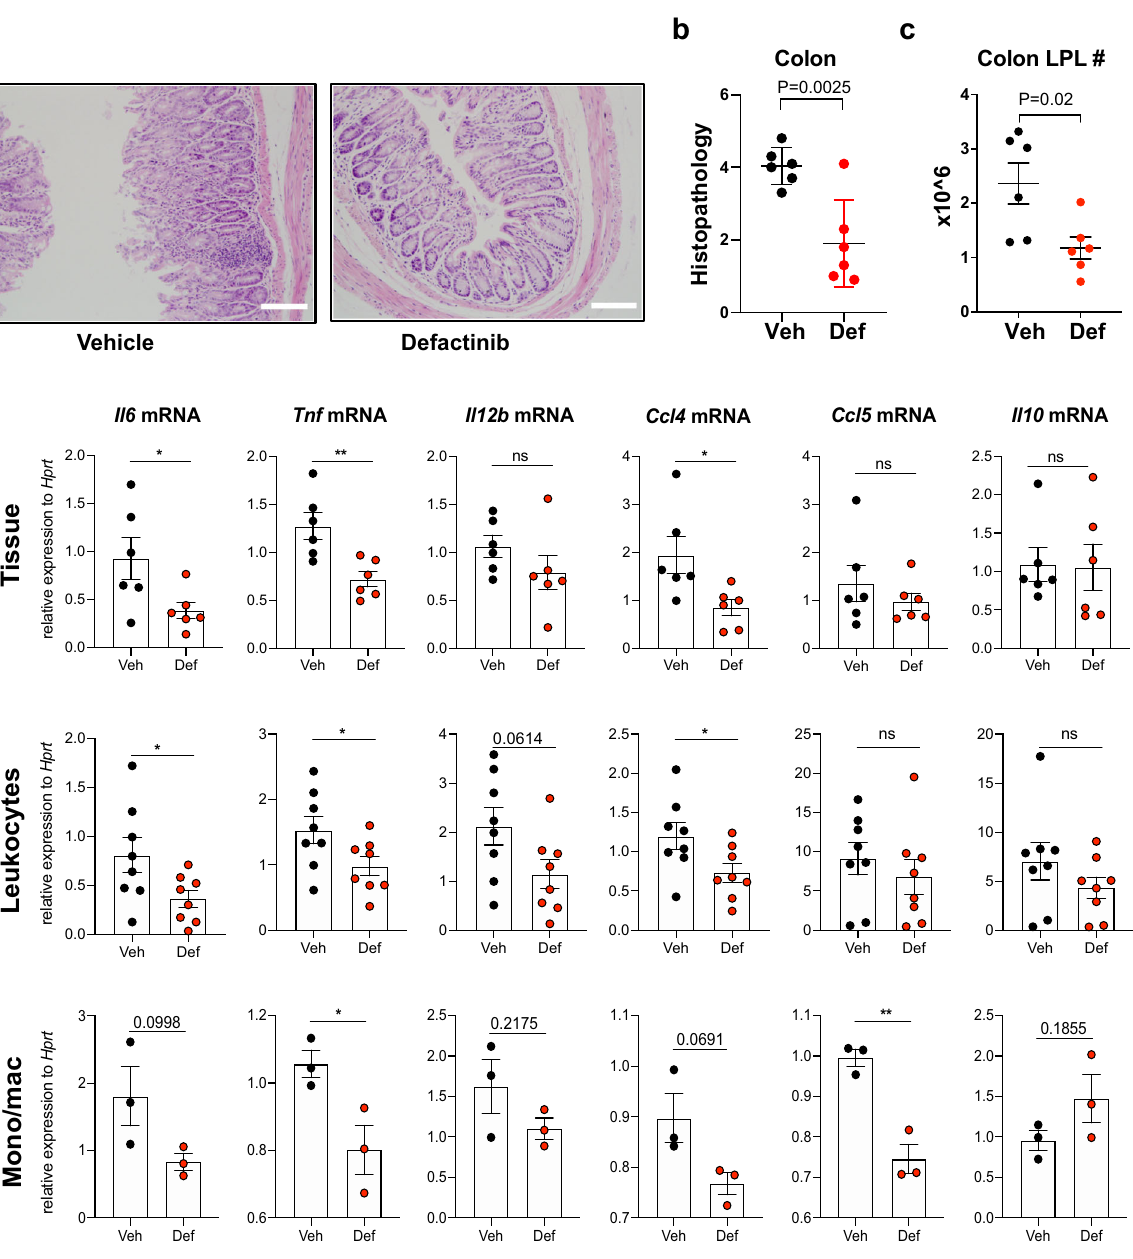
Fig. 6 Defactinib reduces in fl ammation in Hh/anti-IL10R-model of murine colitis. a H&E staining of large intestine tissue sections. Scalebar depicts 100 µ M. b histology scoring and c leucocyte content from Hh /anti-IL10R-treated mice, which received either vehicle or defactinib. Data in ( b , c ) shown as mean values ± SEM from n = 6 mice per condition. Statistical signi fi cance was calculated by a two-tailed unpaired t -test where P = 0.0025 for colon histopathology and P = 0.02 for leucocyte content. d Cytokine/chemokine mRNA expression levels in mouse colon tissue, leucocyte-enriched colonic cells, monocytes/macrophages from a vehicle or defactinib Hh/anti-IL10R treated mice. Data were shown as mean values± SEM from n = 6-8 mice per condition for tissues and leucocytes. Samples were pooled to give n = 3 for monocytes/macrophages. Statistical signi fi cance was calculated by a two-tailed unpaired t -test (* P < 0.05 and ** P < 0.01). Source data are provided as a Source Data fi